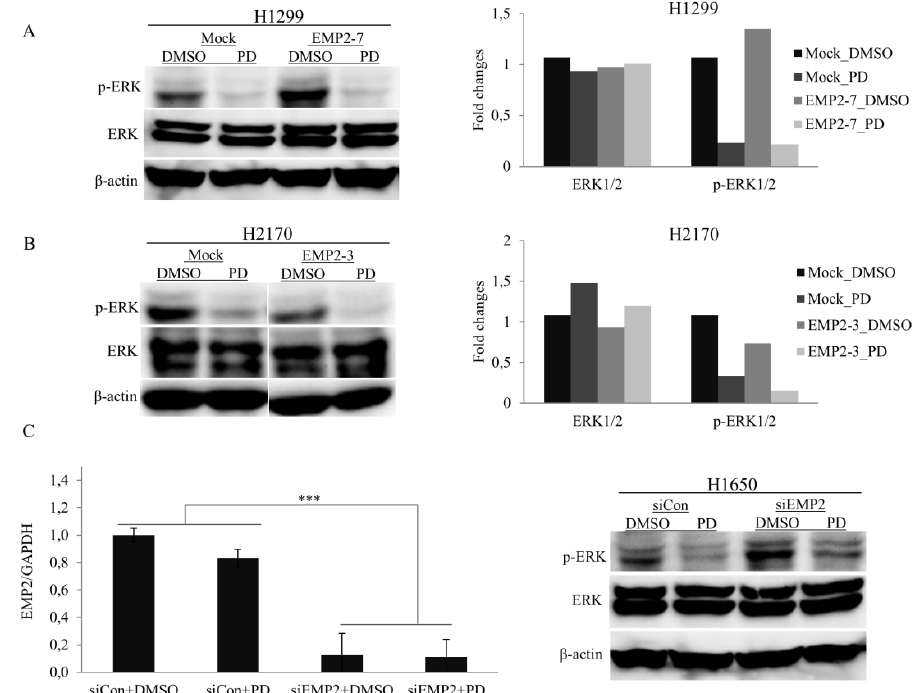
Figure 6. Influence of MEK inhibitor PD98059 (PD) on the expression level of phosphorylated ERK1/2 in NSCLC cells with ectopic expression of EMP2 or EMP2-knockdown. ( A ) PD98059 treatment led to a reduced expression level of p-ERK1/2 in H1299 cells. The expression level of p-ERK1/2 was enhanced in EMP2-transfected H1299 cells (EMP2-7) compared to mock cells after DMSO treatment. No altered expression level of p-ERK1/2 was found in EMP2-transfected H1299 cells compared to mock cells after PD98059 treatment (left). Densitometric quantification of the data from the Western blot analysis (right). ( B ) PD98059 treatment led to a reduced expression level of p-ERK1/2 in H2170 cells. In EMP2-transfected H2170 cells (EMP2-3), a decreased expression level of p-ERK1/2 was observed compared to mock cells after PD98059 treatment (left). Densitometric quantification of the data from the Western blot analysis (right) ( C ) A successful knockdown of EMP2 was confirmed by real-time RT-PCR analysis in H1650 cells treated with DMSO or PD98059 (left). H1650 cells treated with PD98059 showed reduced expression of p-ERK1/2 compared to cells treated with DMSO. Cells with EMP2 knockdown (siEMP2) exhibited more expression of p-ERK1/2 compared to mock cells (siCon) after PD98059 treatment (right). *** p < 0.001 when analyzed using Student’s t